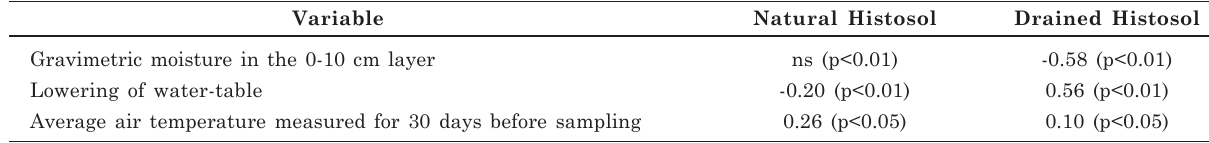
The coefficients of correlation between weekly cumulative rainfall and the methane flux were not included, for not being significant in either soil.